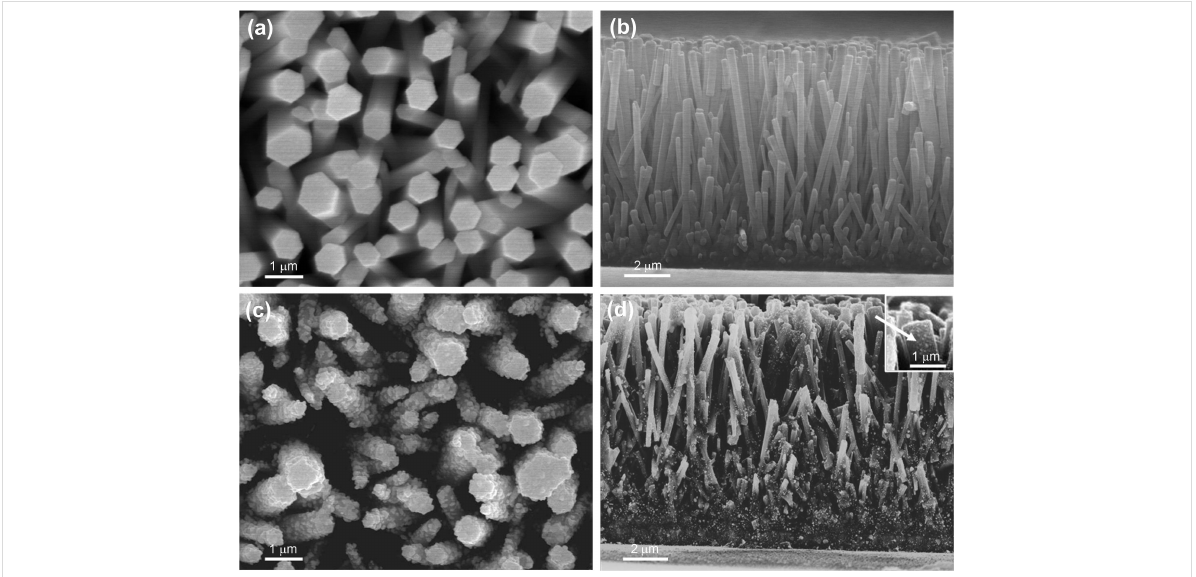
Figure 1: FESEM images showing (a) the top view and (b) the cross-sectional view of the bare ZnO-nanorod photoelectrode, and (c) the top view and (d) the cross-sectional view of the ZnO/Au-nanocomposite photoelectrode. The inset in (d) shows the magnified FESEM image of the Au nanoparti- cles as synthesized on the surface of the ZnO nanorods from a 0.01 mM HAuCl 4 ·H 2 O aq.